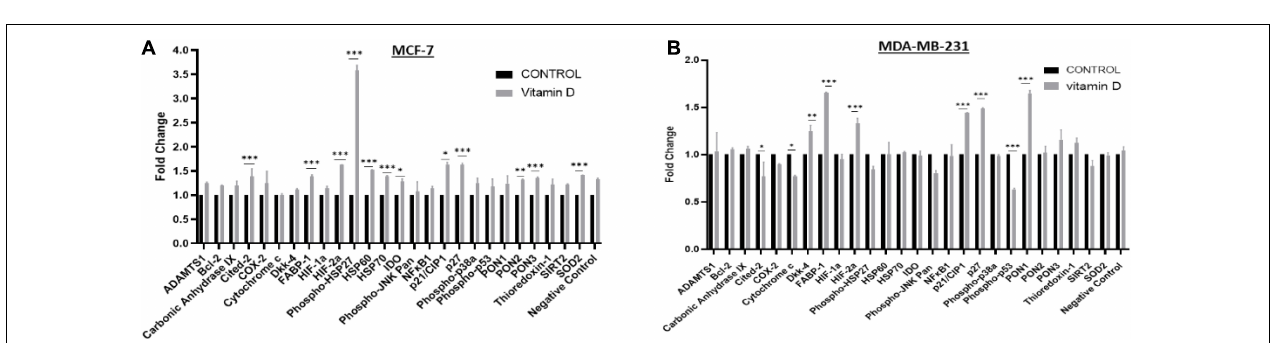
FIGURE 6 | Proteome profiling of cell stress regulators in vitamin D-treated BRCA cells. Expression status of key cell stress regulators in (A) MCF-7 and (B) MDA-MB-231 cells using cell lysates prepared from cells at 24 h post-treatment with vitamin D. *Denotes the presence of statistically significant changes ( p < 0.05) in protein expression in treated vs. control samples. **Represents statistically significant change ( P < 0.01), ***Represents statistically significant change ( P < 0.001).